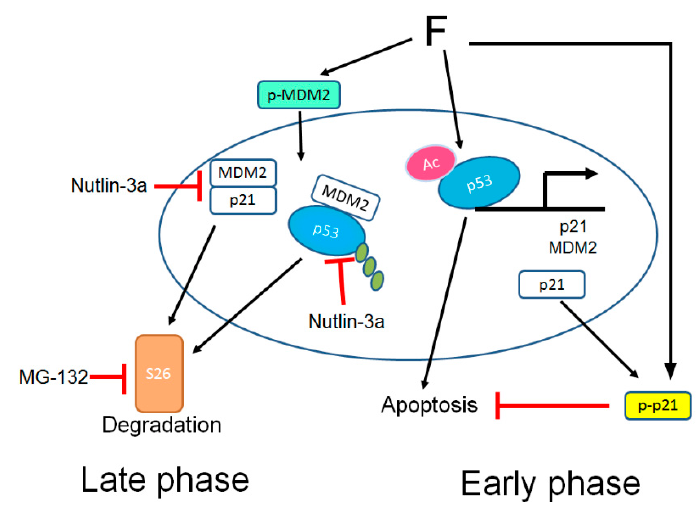
Figure 9. Schema of MDM2-p53 and MDM2-p21 signaling in fluoride toxicity. Fluoride increases acetylated-p53 (Ac-p53) levels to upregulate transcription of Mdm2 and p21 . In the early phase (1–6 h), fluoride induces phosphorylation of p21 (p-p21), which translocates p21 from the nucleus to the cytoplasm where p-p21 counteracts fluoride-induced apoptosis. Fluoride enhances MDM2-p53 and MDM2-p21 formation to promote MDM2-mediated p53 and p21 proteasomal degradation that leads to p21 and p-p21 attenuation in the late phase (24 h). Nutlin-3a inhibits MDM2-p53 and MDM2-p21 binding. Nutlin-3a or MG-132 (proteasome inhibitor) reverses fluoride-induced p21 attenuation and increases p-p21 to suppress fluoride-mediated